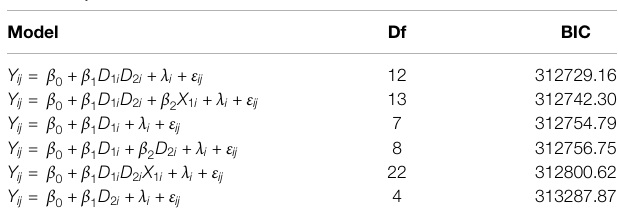
To test the hypothesis that these neurons could be subject to dopamine modulation, we modi fi ed the previous protocol by adding a dopamine application 10 min before the stimulation ( Figure 5A ). The R2 neurons showed an enhanced Ca 2+ -response to nicotine after dopamine application compared to the condition without dopamine ( Figure 5B ). However, to better understand the extent of the dopamine modulation, we fi tted the data with different LME models considering several predictors: “ condition ” that distinguishes the responses with or without dopamine application; “ ROIs ” that refers to the different regions innervated by the driver line (e.g., cell body, EB and BU); and “ time ” that refers to the time window during which the responses were unfolded. For the R2 neurons we de fi ned fi ve ROIs encompassing all the EB, the two lateral superior BU and the two lateral groups of cell bodies (cb). We computed the BIC for the LME model comparisons and the best one took into account